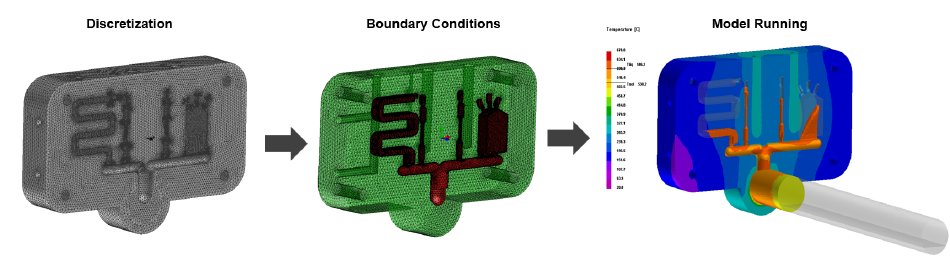
Figure 5. Physics-based model setup and